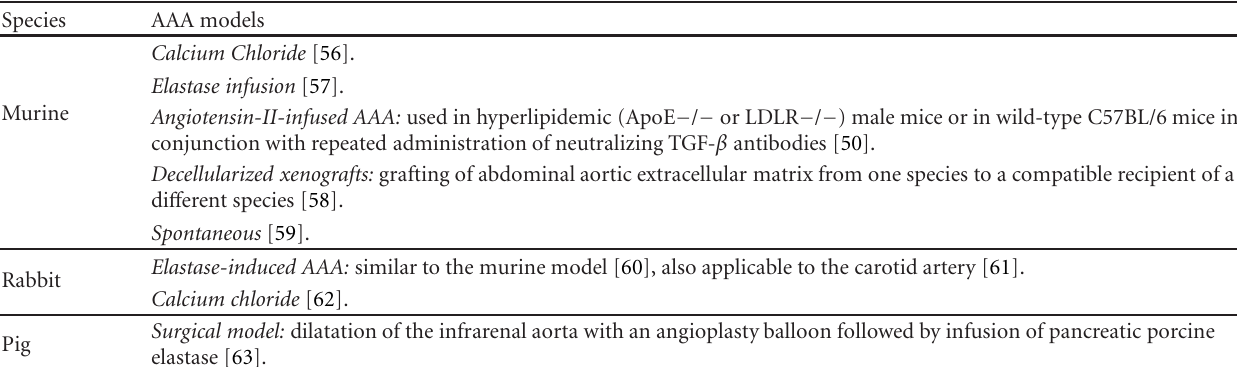
Table 3: Current procedures for inducing AAA in